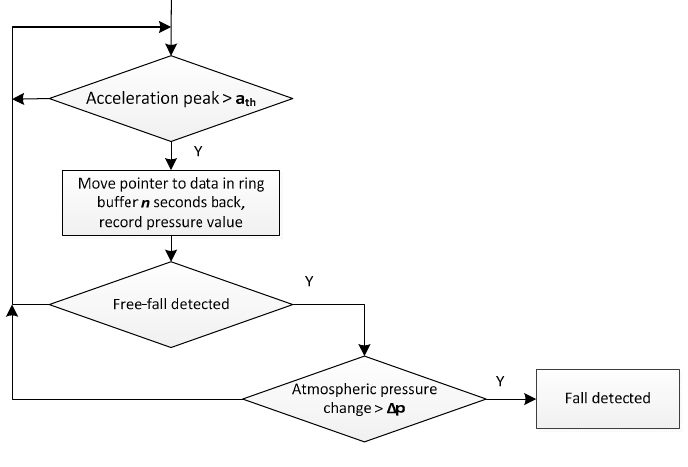
Figure 12. Acceleration and atmospheric pressure variations during the fall (experimental data).